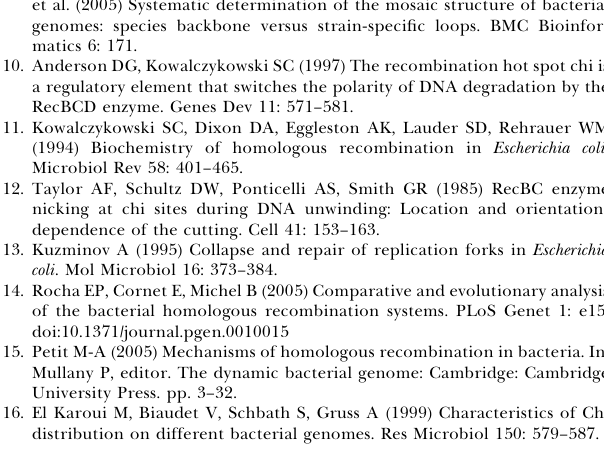
Table S4. The L. lactis Chi site Is Active in S. pneumoniae Total DNA extracts from the wild-type strain carrying a plasmid with the putative Chi site show increased transformation efficiency,